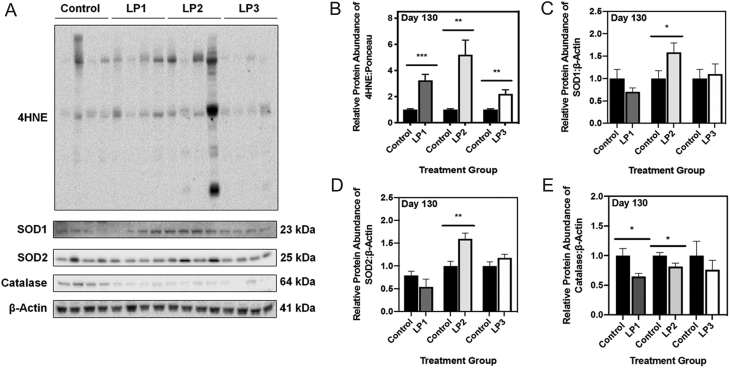
Maternal protein restriction leads to increased markers of hepatic oxidative stress at 4 months of age. (A) Representative Western immunoblots illustrating expression of 4-hydroxynonenal, a marker of lipid peroxidation, superoxide dismutase (SOD)1 and SOD2 in LP1, LP2 and LP3 offspring relative to control diet-fed offspring. Protein abundances of (B) 4HNE, (C) SOD1, (D) SOD2, and (E) catalase in each group of MPR offspring were each compared against control offspring. 4HNE abundance was expressed as means normalized to total protein abundance ± s.e.m. (n = 7–8/group), while SOD1, SOD2 and catalase abundance was normalized to β-Actin ± s.e.m. (n = 7–8/group). All protein abundances were analyzed using a two-tailed unpaired Student’s t-test. *Significant difference (P < 0.05), **significant difference (P < 0.01), ***significant difference (P < 0.001).